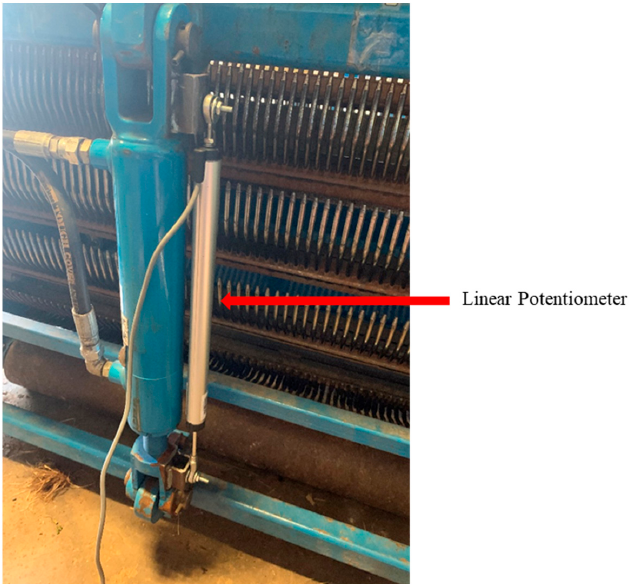
Figure 4. DBE harvester head showing the placement of the linear potentiometer in line with the hydraulic actuator.